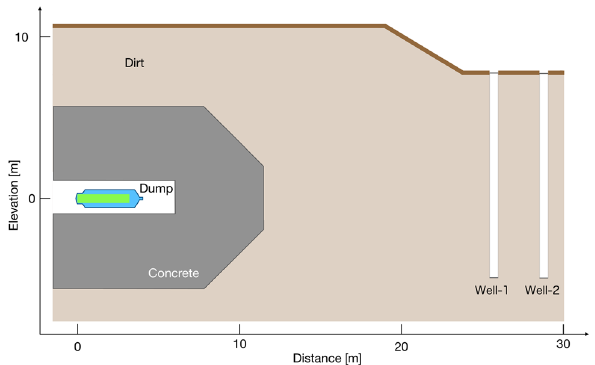
Fig. 1 Schematic representation of the location of the wells relative to the Hall-A beamdump. From left to right, the Hall-A aluminum-water beamdump (blue-green), the concrete beam-vault walls (gray), the dirt (brown), and the two vertical pipes. The detector was located in the well closest to the accelerator, Well-1